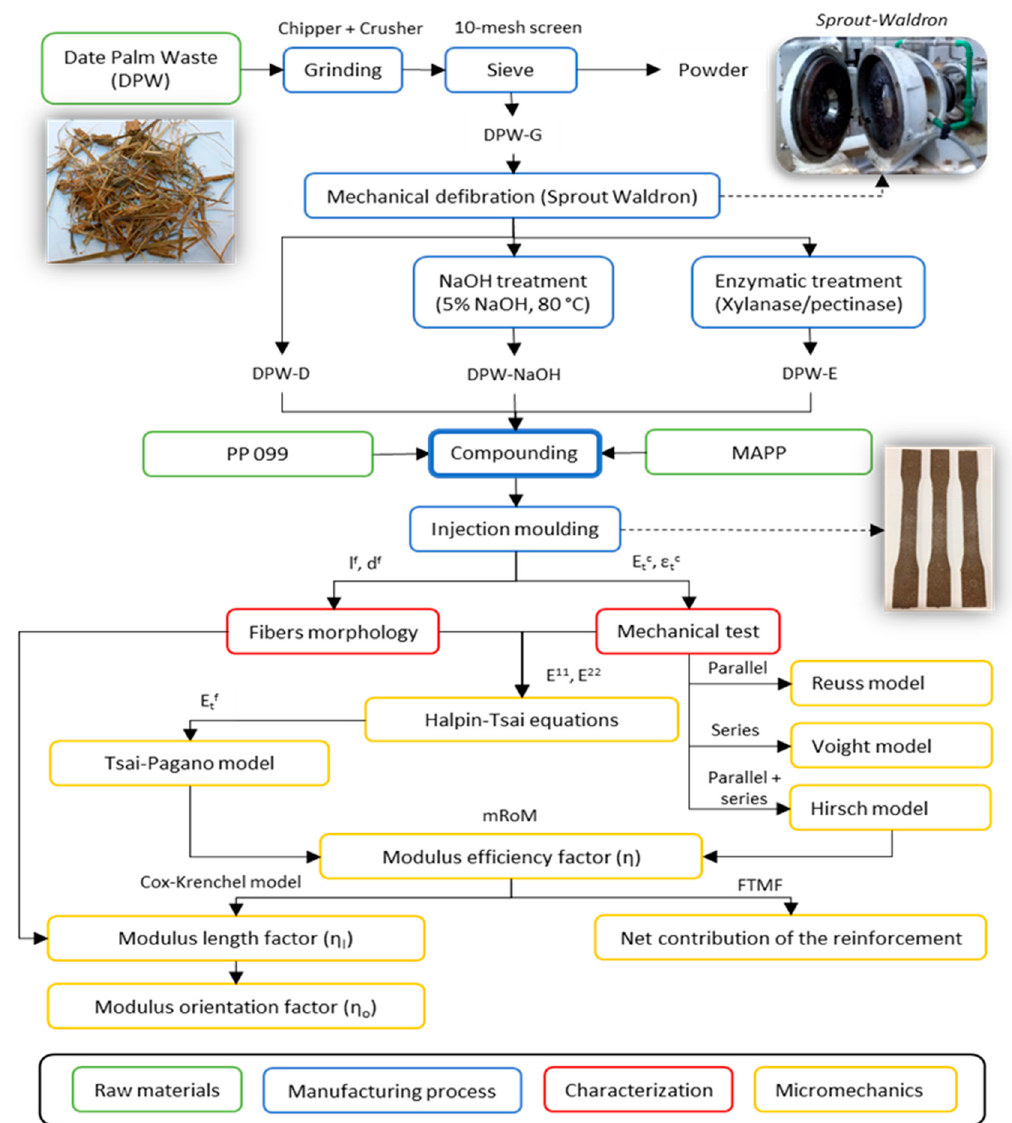
Figure 1. Flowchart of the present investigation.